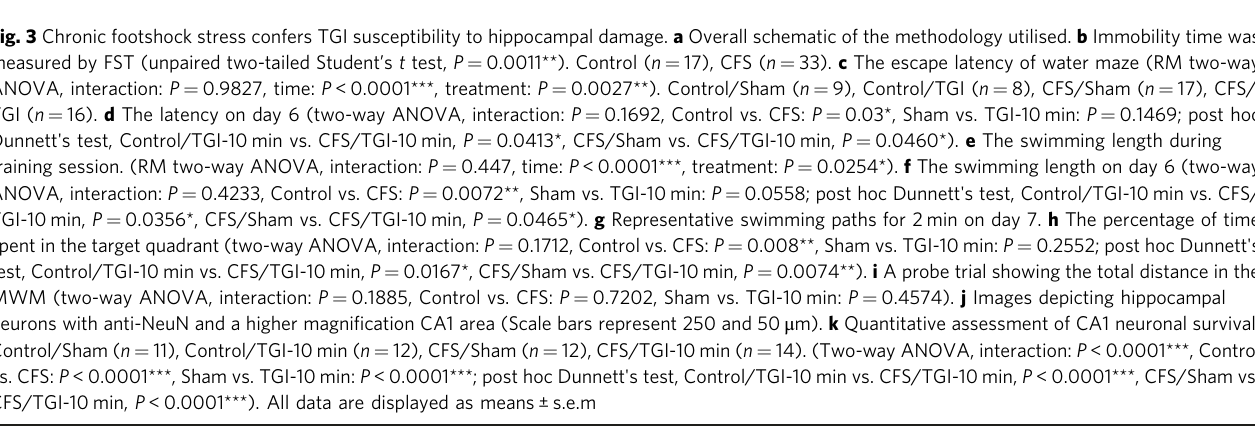
Fig. 3 Chronic footshock stress confers TGI susceptibility to hippocampal damage. a Overall schematic of the methodology utilised. b Immobility time was measured by FST (unpaired two-tailed Student ’ s t test, P = 0.0011**). Control ( n = 17), CFS ( n = 33). c The escape latency of water maze (RM two-way ANOVA, interaction: P = 0.9827, time: P < 0.0001***, treatment: P = 0.0027**). Control/Sham ( n = 9), Control/TGI ( n = 8), CFS/Sham ( n = 17),